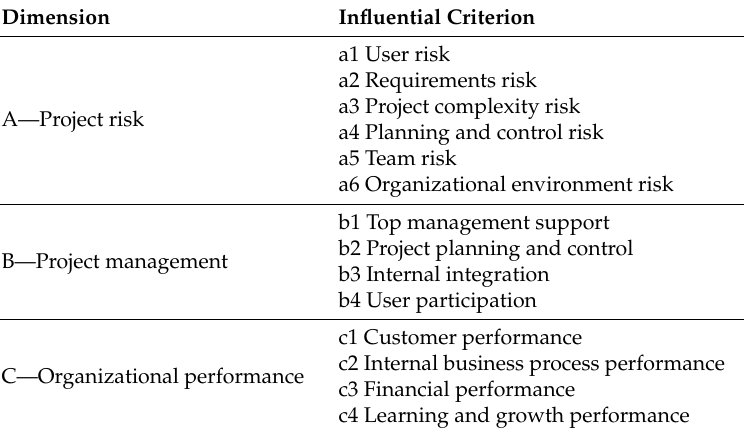
Table 4. Dimensions and influential criteria of the research